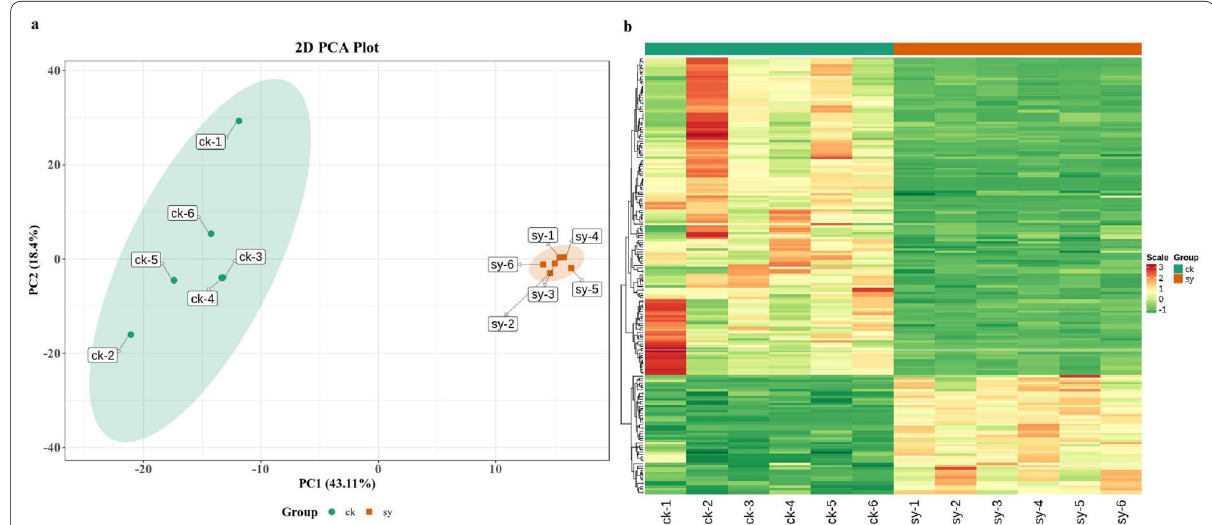
Fig. 2 Metabolome profiling in P. digitatum in responding to X33 AMOP treatment. a Principal component analysis of metabolites accumulated in the control and X33 AMOP-treated samples. b Heatmap results of the metabolites accumulated in control and X33 AMOP-treated samples. Ck1 ~ ck6 represents the control group displayed six repetition. Sy1 ~ sy6 represents the X33 AMOP-treated group displayed six